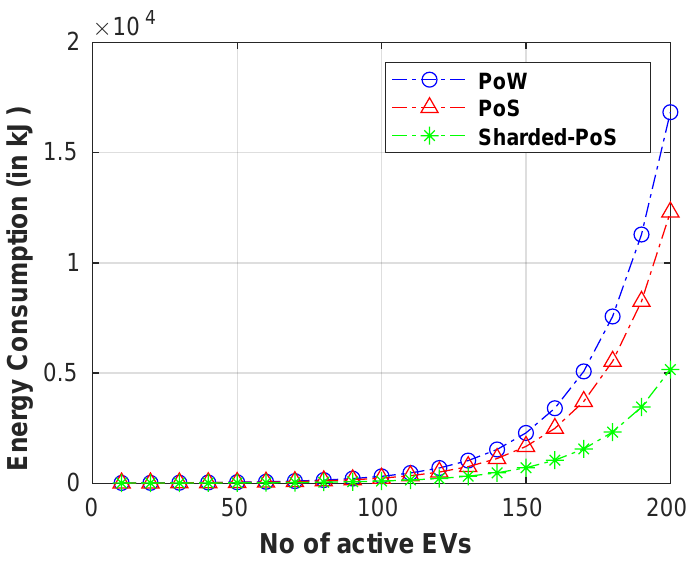
Figure 8. Energy consumption by active